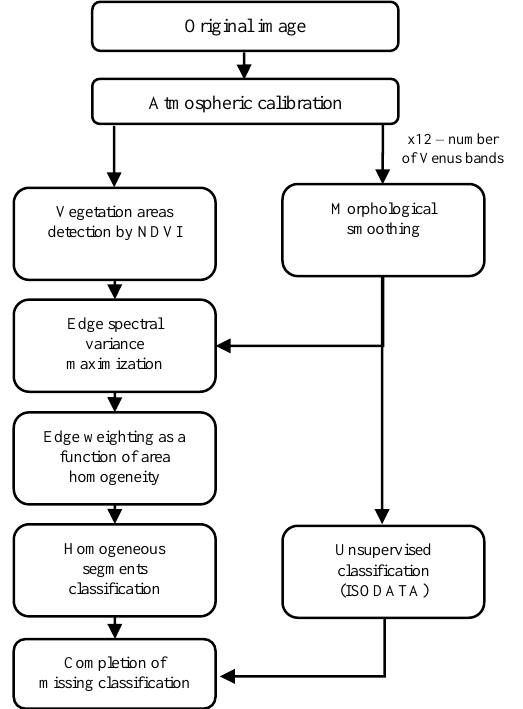
Figure 2: The general research methodology